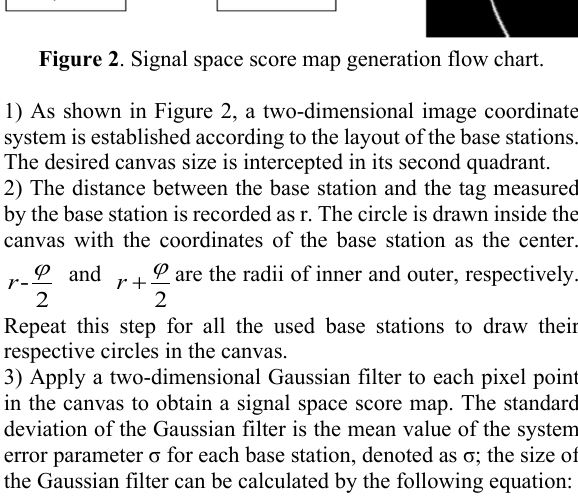
Figure 3 . Structural diagram of full convolutional neural network.